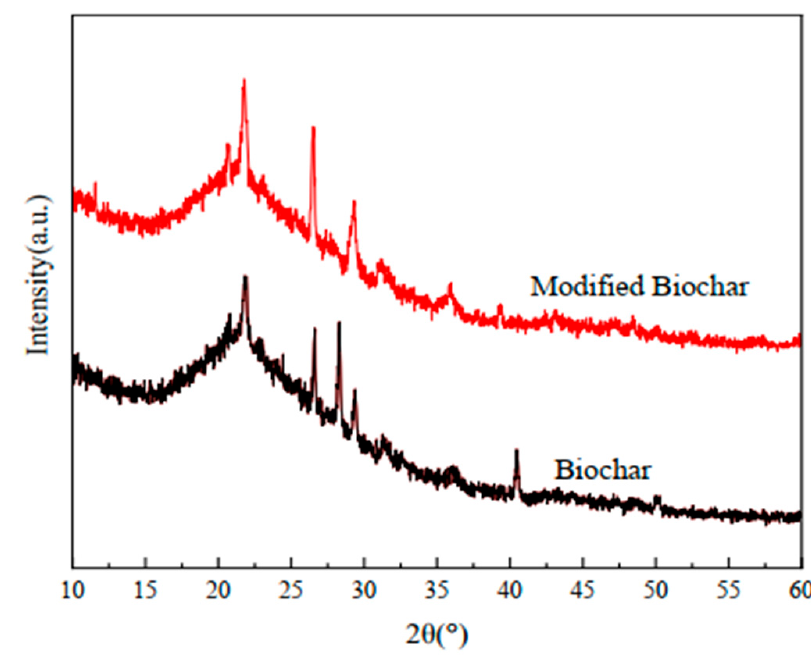
Figure 7. X-ray diffractometer images of biochar before and after modification.